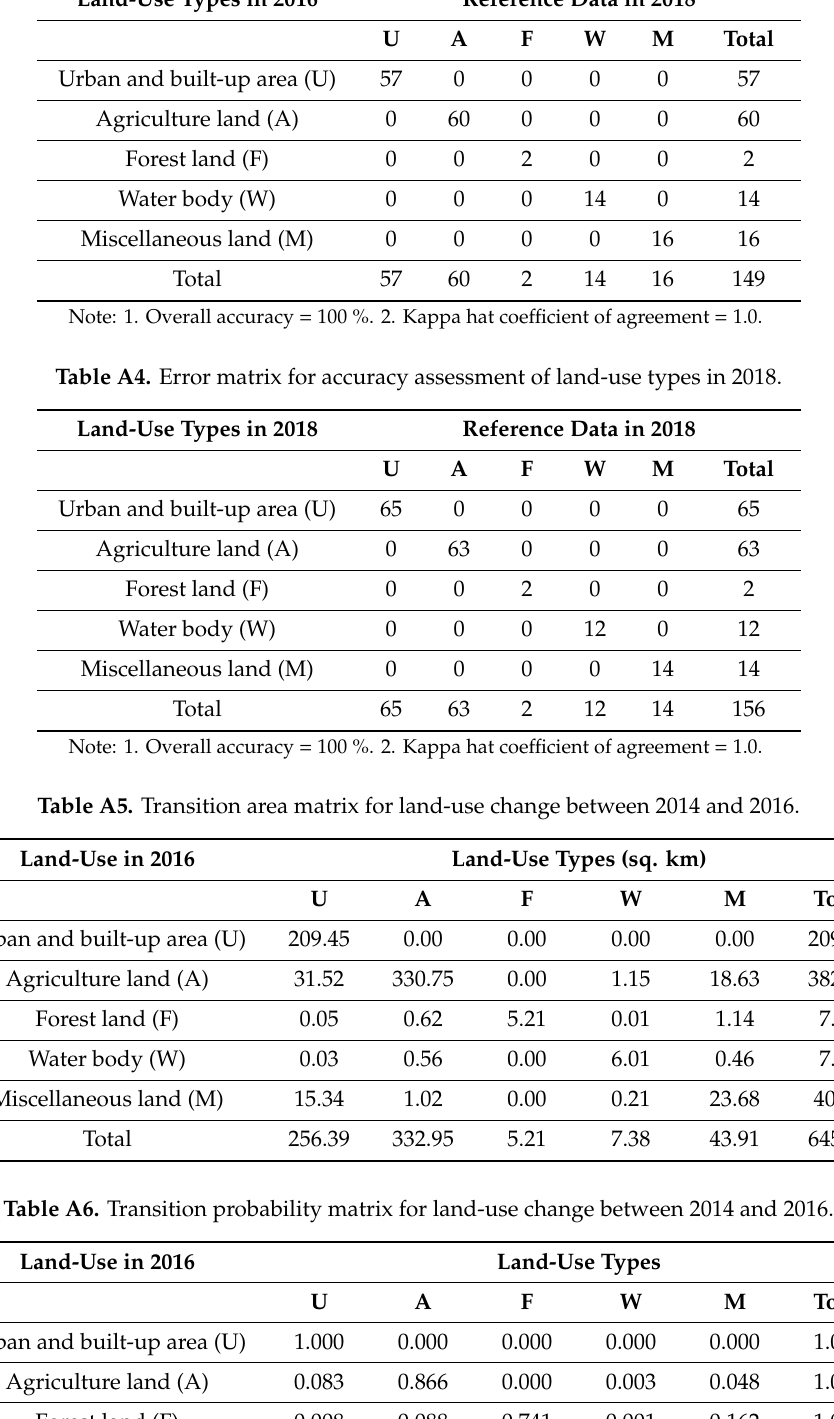
Table A3. Error matrix for accuracy assessment of land-use types in 2016. Land-Use Types in 2016 Reference Data in 2018